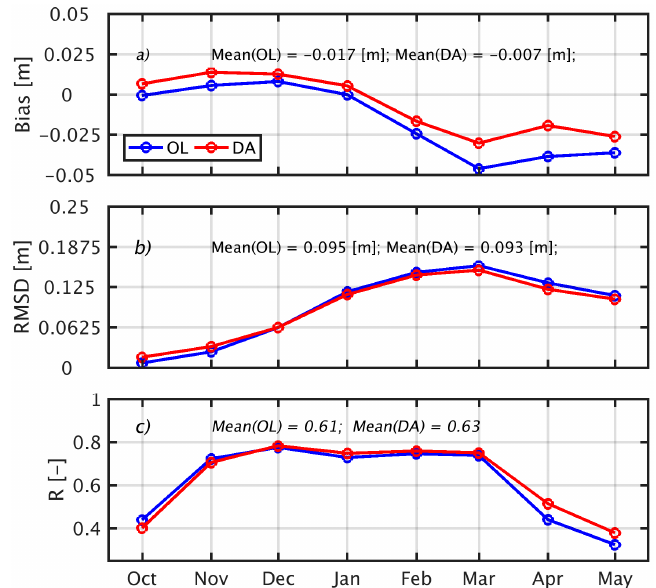
Figure 6. Seasonal variation of OL (blue) and DA (red) versus CMC snow depth showing: ( a ) bias; ( b ) RMSD and; ( c ) spatial correlation coefficient (R) across the conterminous US north of 35 degrees latitude for the period October 2001 to October 2009.